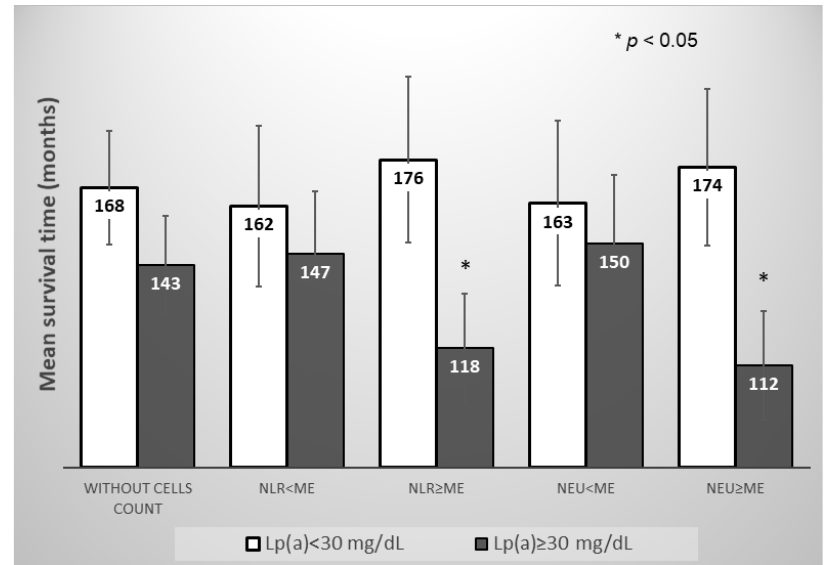
Figure 5. Mean survival time without MACE in subgroups of patients depending on the of Lp(a) concentration, the neutrophils blood count, or the neutrophil-to-lymphocyte ratio. NLR—neutrophil-to-lymphocyte ratio, NEU—neutrophil, Me—median. Median for NLR = 2.66, for Neu = 5.04 × 10 9 /L.